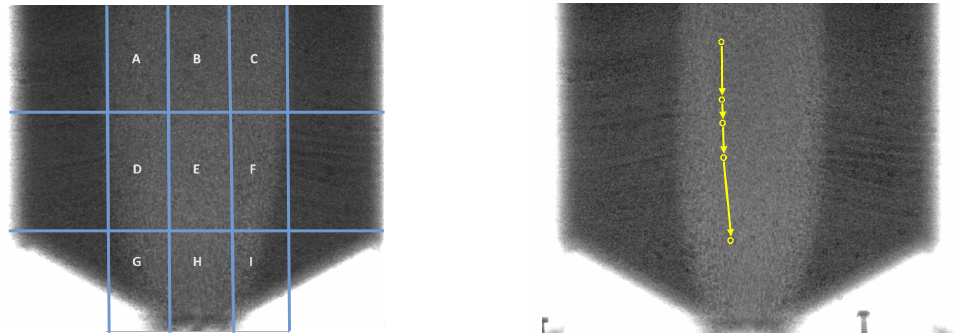
Figure 4. Comparison of the zone-targeted mode and single-particle-targeted method of crowdsourcing: (left) grid showing velocity calculation zones used as target zones in the zone-targeted tracking method; (right) illustration of single-particle-targeted method for tracking an arbitrary trace